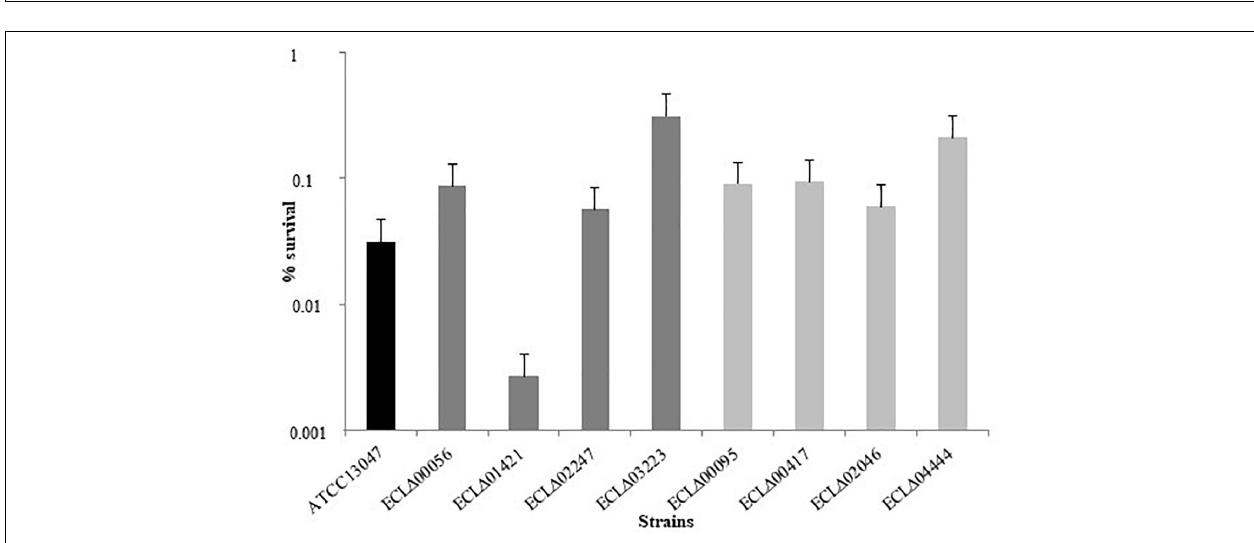
FIGURE 2 | Percentage of survival of the different E. cloacae strains after 30 min in the presence of 20 mM H 2 O 2